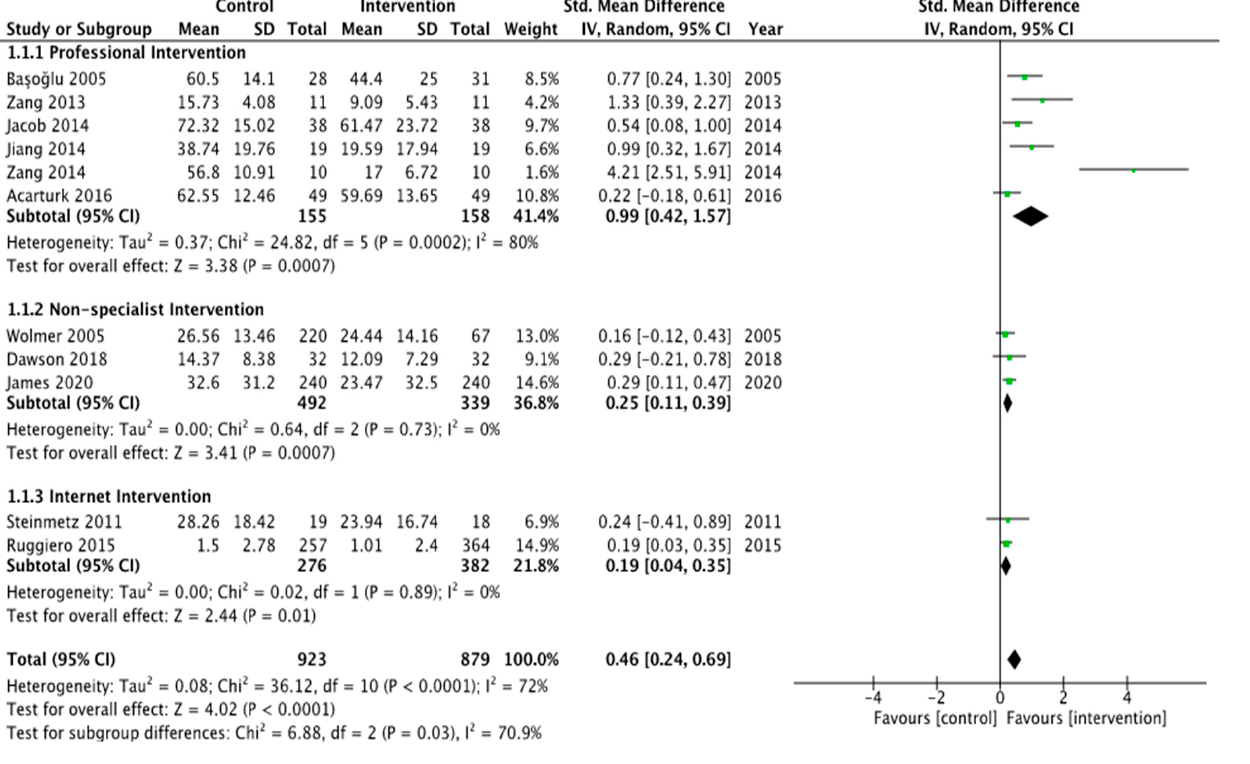
Comparison of Non-Specialists’ Mental Health Interventions Versus PTSD